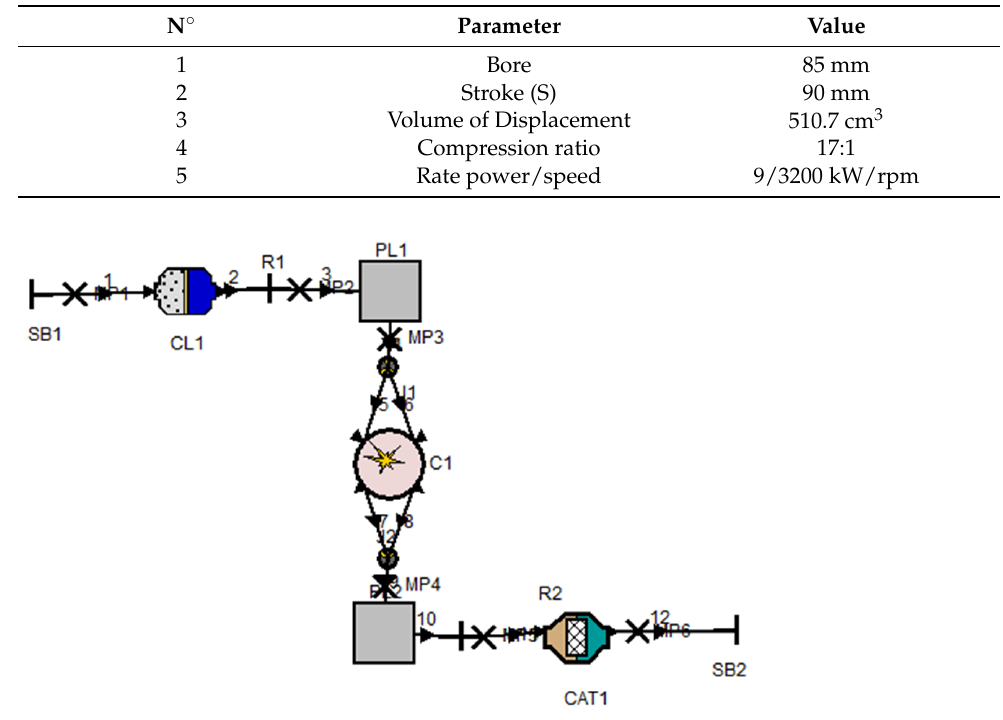
With: Q wi : wall heat flow; A i : surface area; α w : heat transfer coefficient; T c : gas temperature in the cylinder; T wi : wall